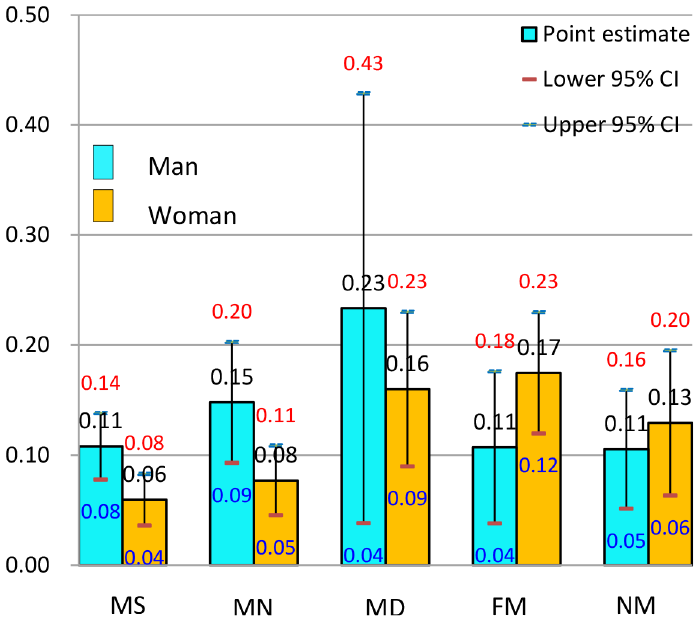
Fig 2. Predicted probability (and 95% confidence intervals) of reporting poor health by gender in Japan, the 2006 East Asian Social Survey.